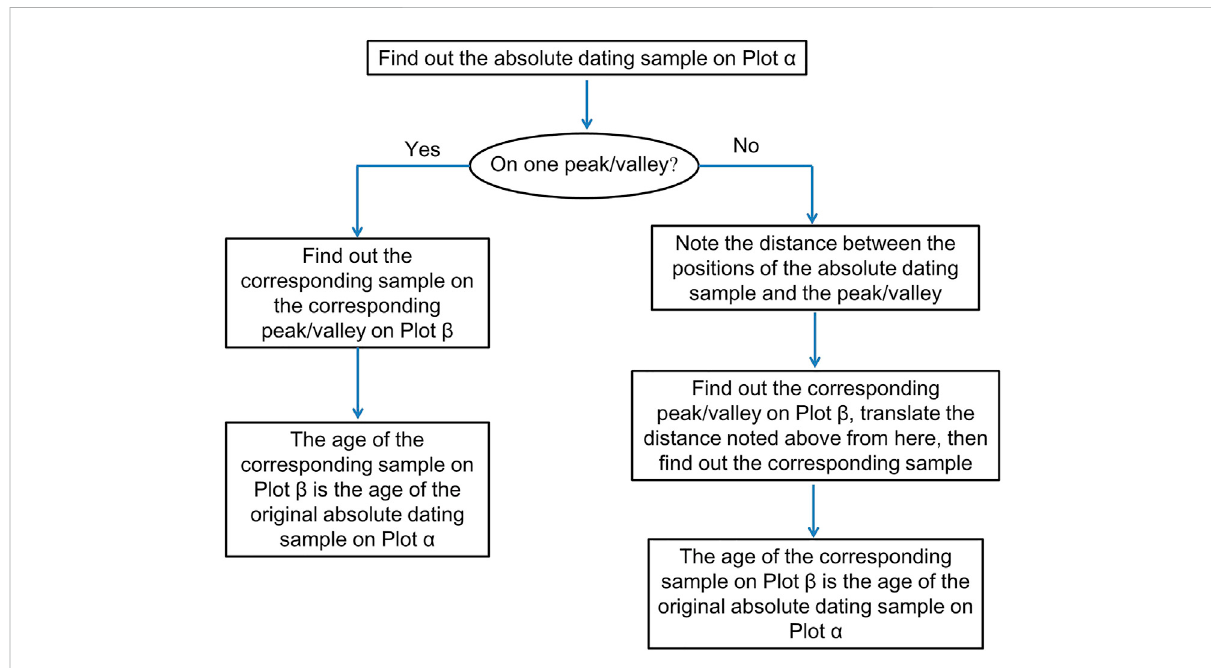
FIGURE 3 Steps in the relative dating by the proxy-depth plots for multiple cores. The proxy-depth plot with the absolute dating samples is designated as Plot α , and the plot of the same proxies of the core to be dated is designated as Plot β